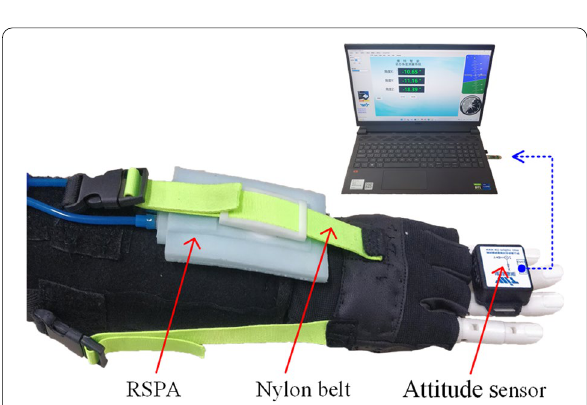
Figure 6 Test system for wearable rehabilitation